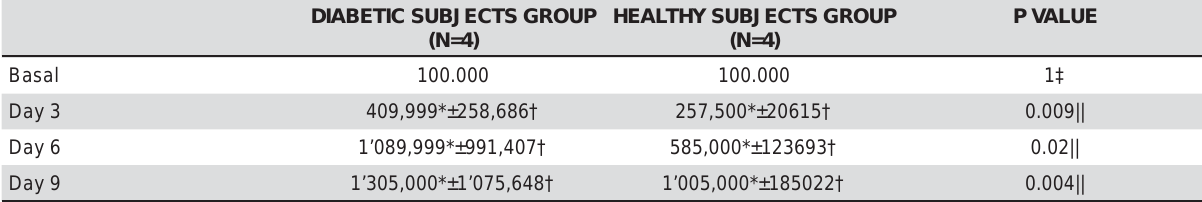
||Match paired Student´s T-test